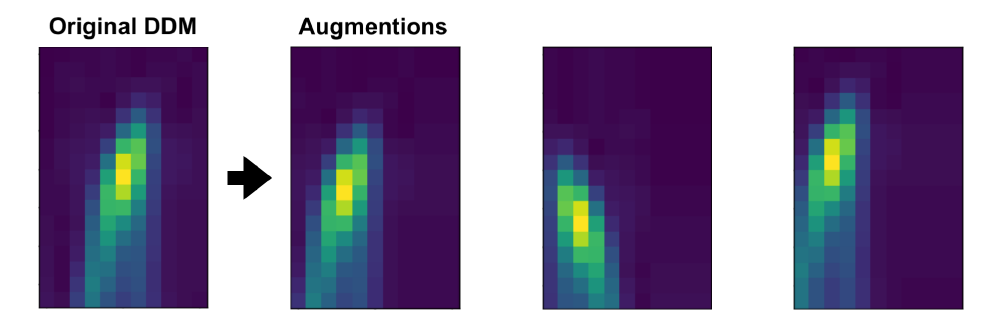
Figure 8. Example of randomized image augmentation (translations/reflections) applied to a DDM (horizontal and vertical translations are exaggerated for illustrative